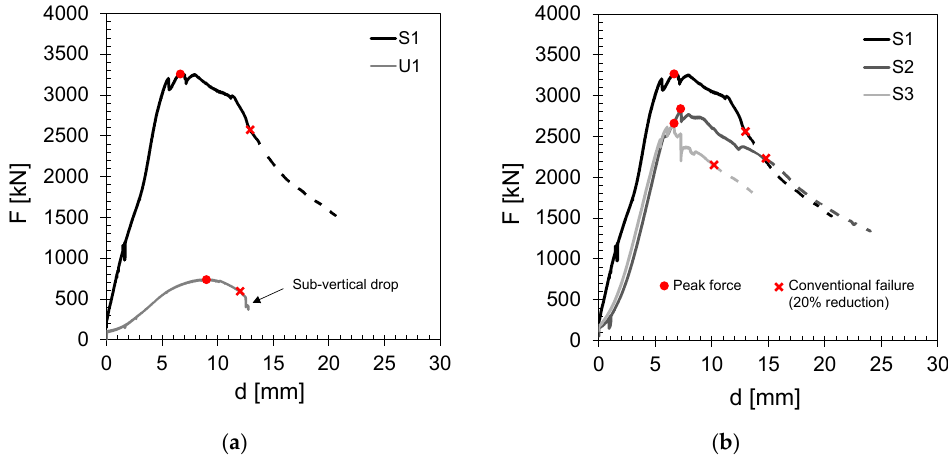
Figure 6. Axial load vs. displacement (F-d) diagrams for specimens: U1–S1 ( a ); S1–S2–S3 ( b ). Table 4. Main recorded experimental